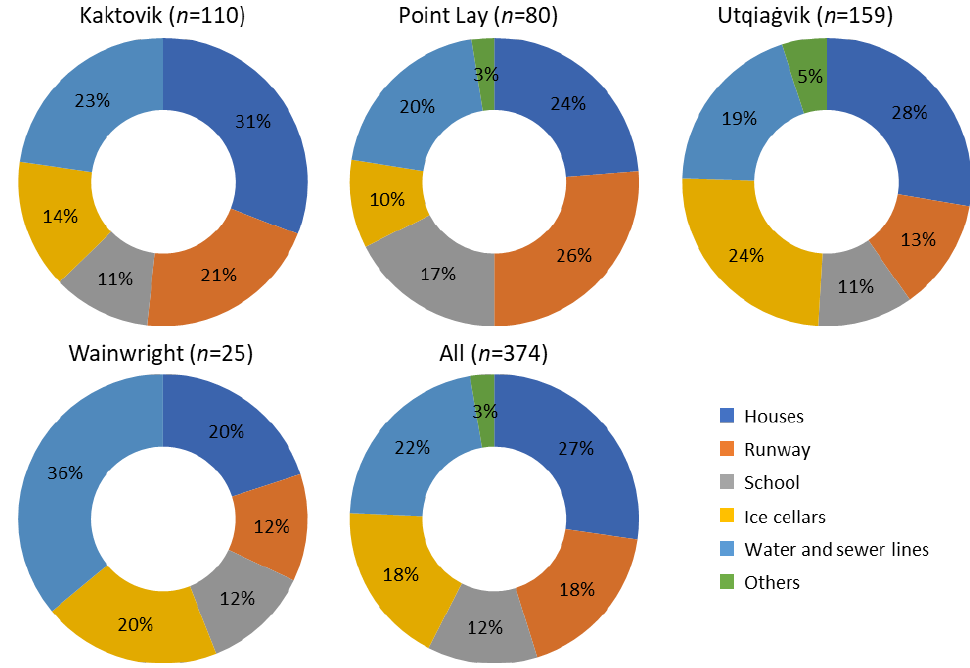
Figure 5. Types of civil infrastructure that are affected by permafrost thaw. n is the sample size. Table 3. Modeled increase in active layer thickness and subaerial talik formation between 2020 and 2100 (RCP 8.5) (adapted from [3]).